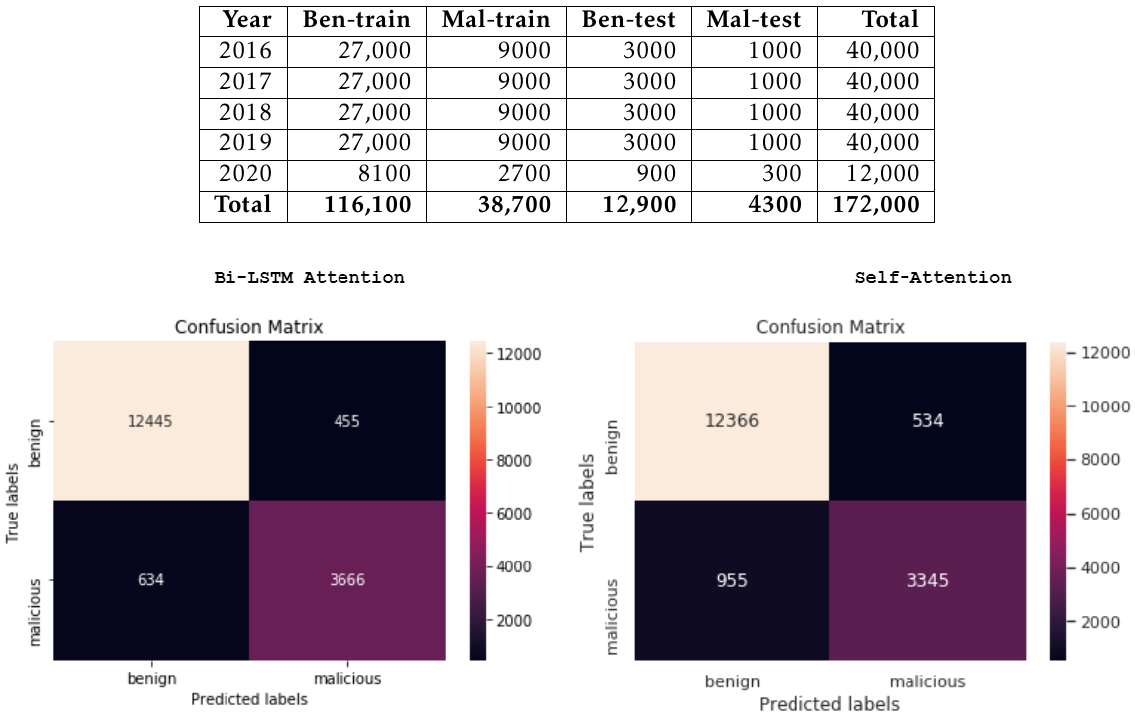
Figure 6. Confusion matrix for Bi-LSTM Attention (Left) and Self-Attention (Right)